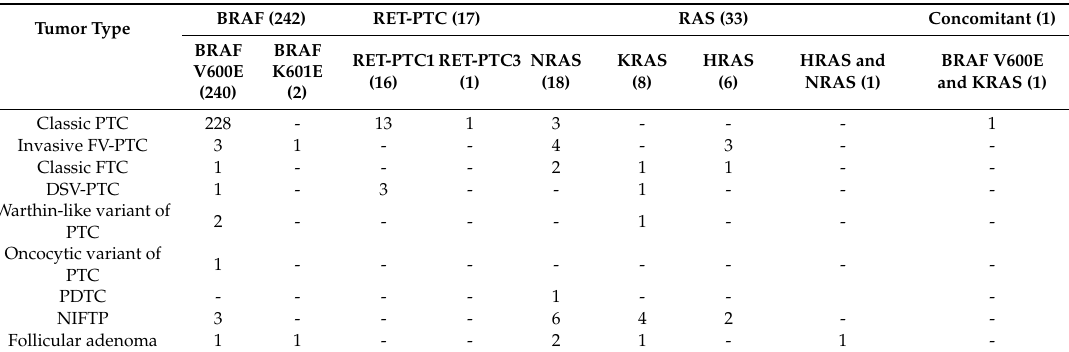
Table 1. Molecular distribution and histological